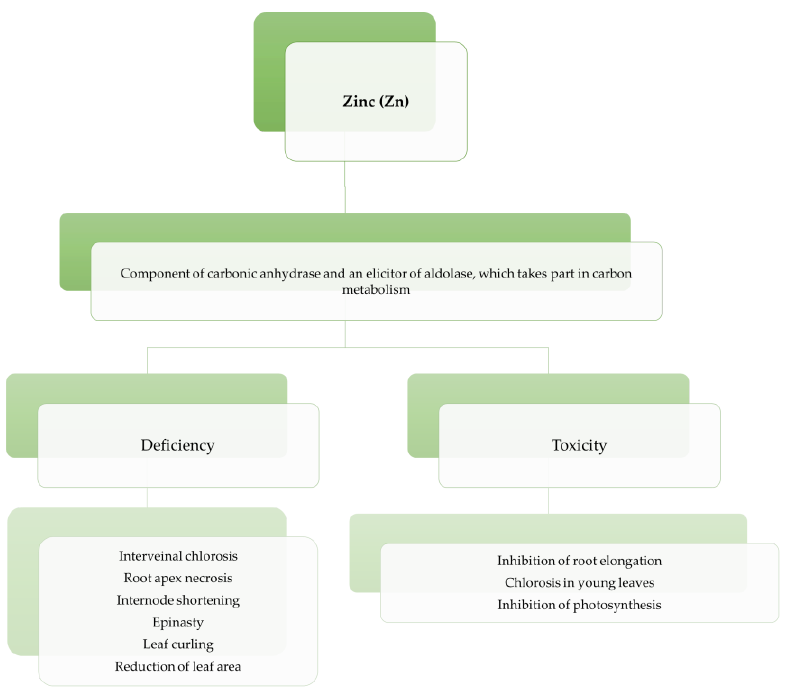
Figure 2. Main effects of zinc (Zn) in plants.